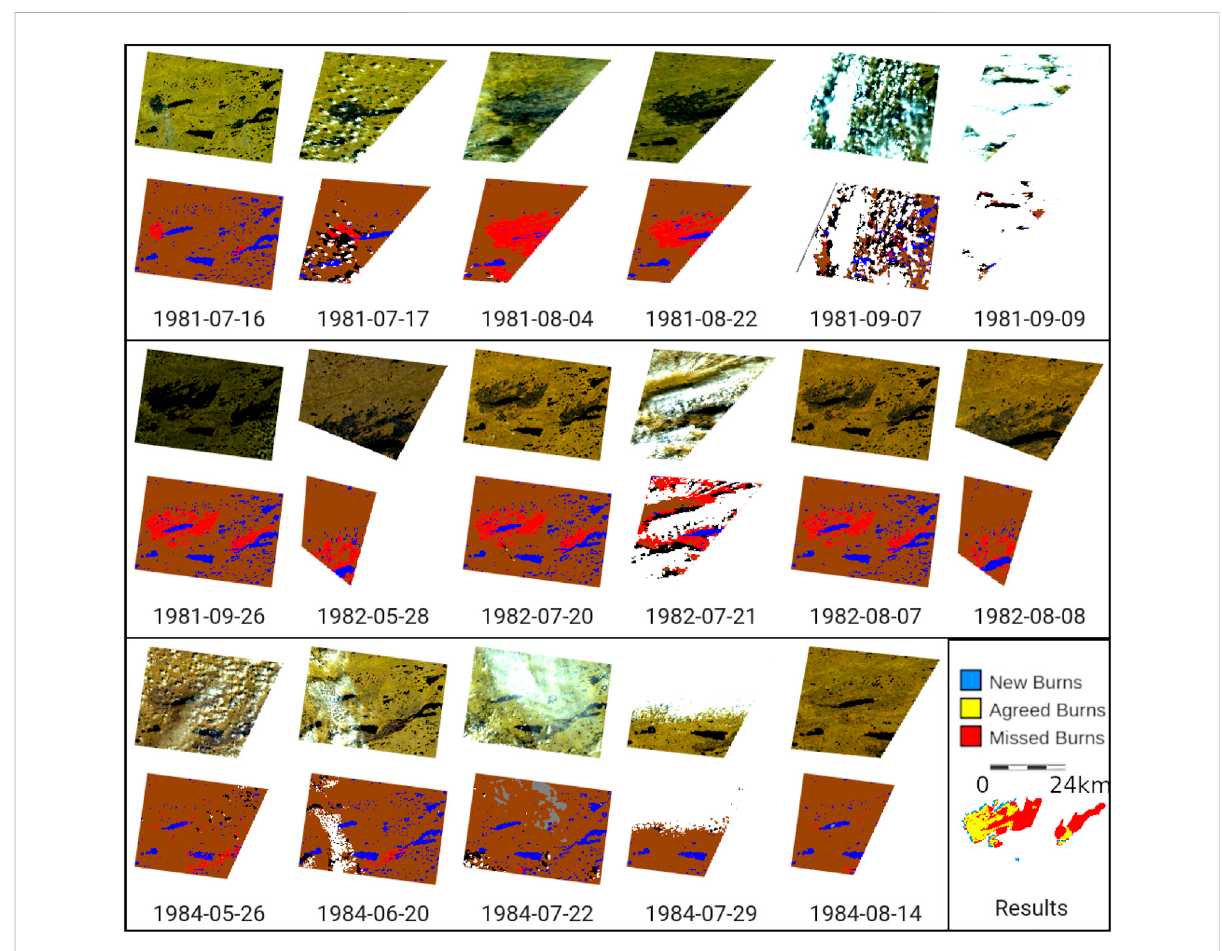
FIGURE 10 Results Detail H. Every Usable MSS image and UNet classi fi cation of a fi re that started 1981 – 07-13 according to the CNFDB, but was only partially detected by our